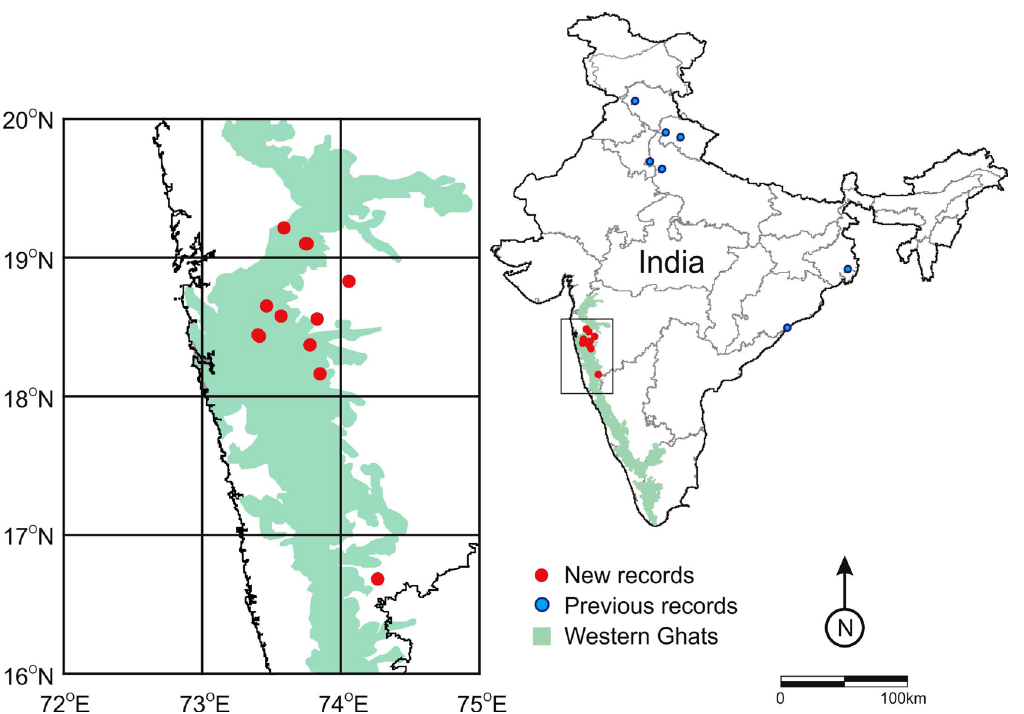
Figure 1. Map depicting distributional records of S. (Discolia) fasciatopunctata dunensis in India.